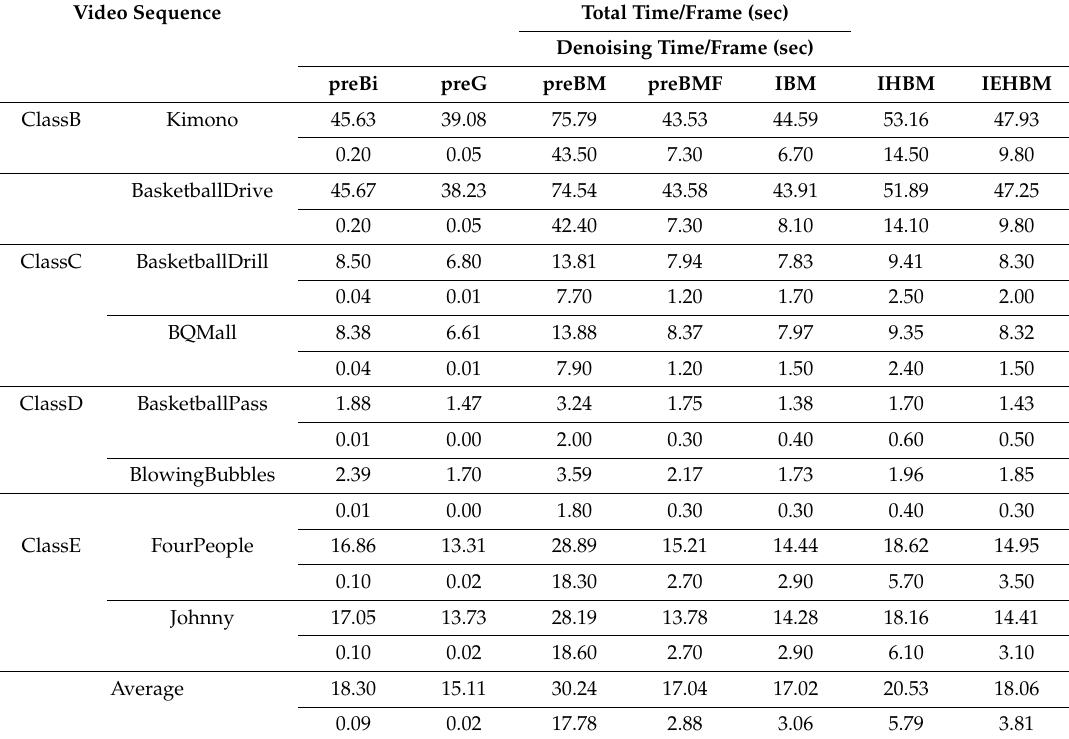
Table 3. Comparison of processing time for noisy video